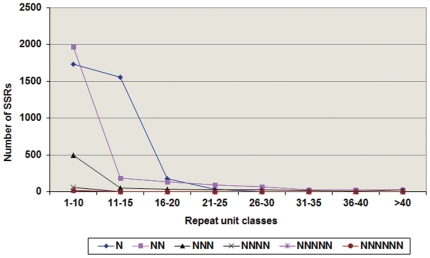
Distribution of microsatellites with varying repeat units in BAC-end sequences.N: mono-nucleotide repeats; NN: di-nucleotide repeats; NNN: tri-nucleotide repeats; NNNN: tetra-nucleotide repeats; NNNNN: penta-nucleotide repeats and NNNNNN: hexa-nucleotide repeats.